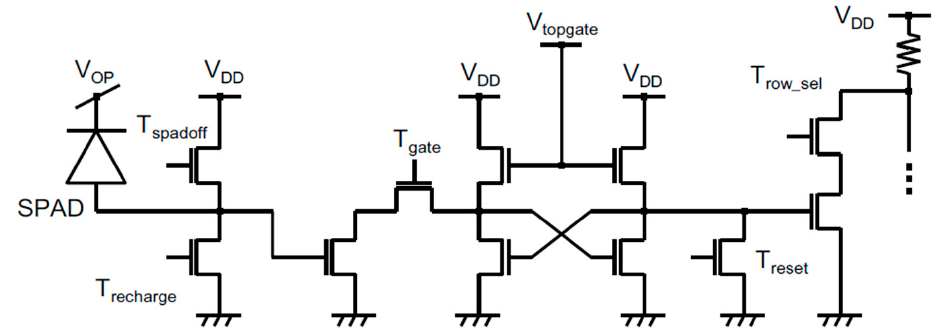
Figure 7. Pixel schematic diagram of the 128 × 128 time-gated SPAD camera in [63].